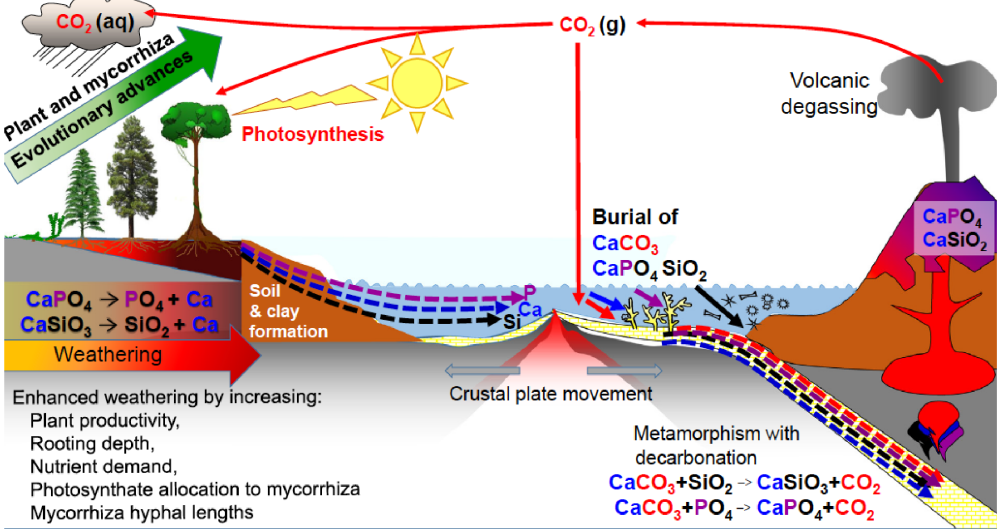
Figure 4. The effects of evolutionary advancement in plants and mycorrhizal associations in the geochemical carbon cycle, increasing the weathering of calcium (Ca)-, phosphorus (P)-, and silicon (Si)-bearing minerals and generating clays. Plants and their mycorrhizal fungi have increased the rates of dissolution of continental silicates, especially calcium silicate (CaSiO 3 ), and apatite (Ca phosphate-CaPO 4 ), but a portion of the Ca, P and Si released from rocks is washed into the oceans where these elements increase productivity. Some of the Ca and P ends up in limestone and chalk deposits produced by marine organisms such as corals and foraminifera, thereby sequestering carbon dioxide (CO 2 ) that was dissolved in the oceans into calcium carbonate (CaCO 3 ) rock for millions of years. Dissolved Si is used in sponges, radiolarians and diatoms that can accumulate on the sea floor. The ocean sediments are recycled by subduction or uplift by tectonic forces, with volcanic degassing and eruptions of base-rich igneous rocks such as basalt returning Ca, P, Si and other elements back to the continents, thereby reinvigorating ecosystems with new nutrient supplies through weathering. Note for simplicity that magnesium is not shown in the figure but follows parallel pathways to Ca and is co-involved in sequestering CO 2 into dolomitic limestones. aq, liquid state; g, gaseous state. (Figure is reproduced with permission: Leake and Read,